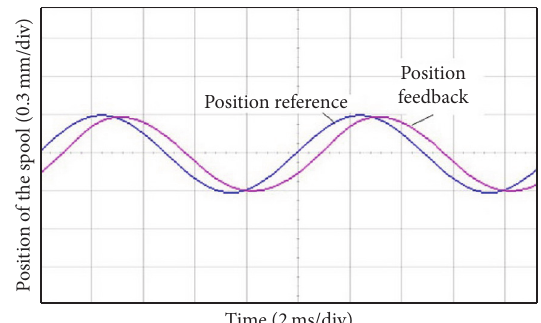
Figure 11: Experimental results of the 100 Hz sinusoid trajectory tracking using RBF-ESO